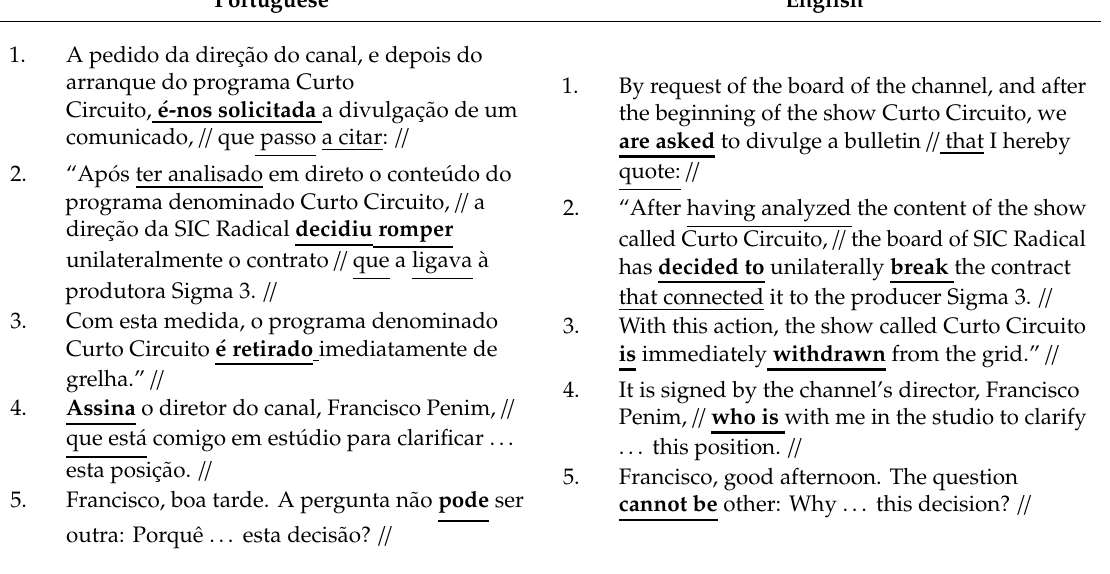
Figure A5. Stimulus 5—Pitch structure. Figure A6. Stimulus 5—Pitch structure. Table A5. Stimulus Table A5. Stimulus 5—Transcription.